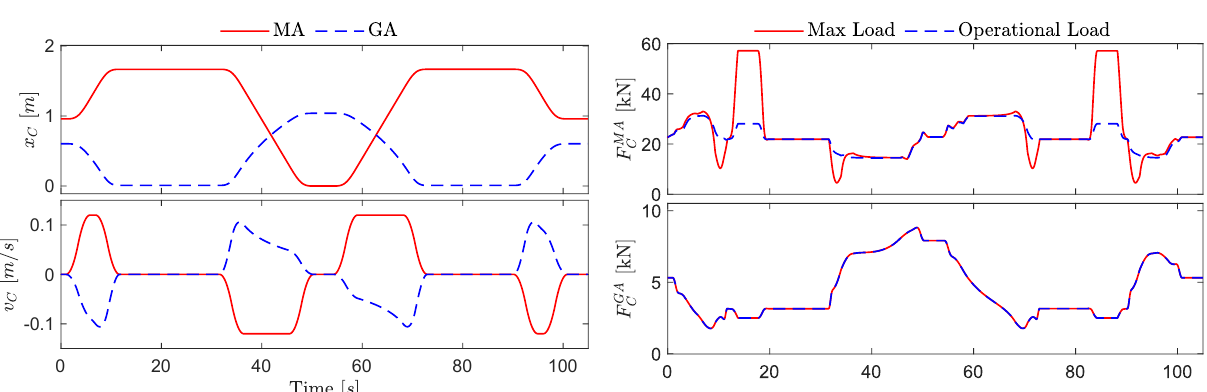
Figure 14: MA and GAs motion reference: (top) position; (bottom) velocity.